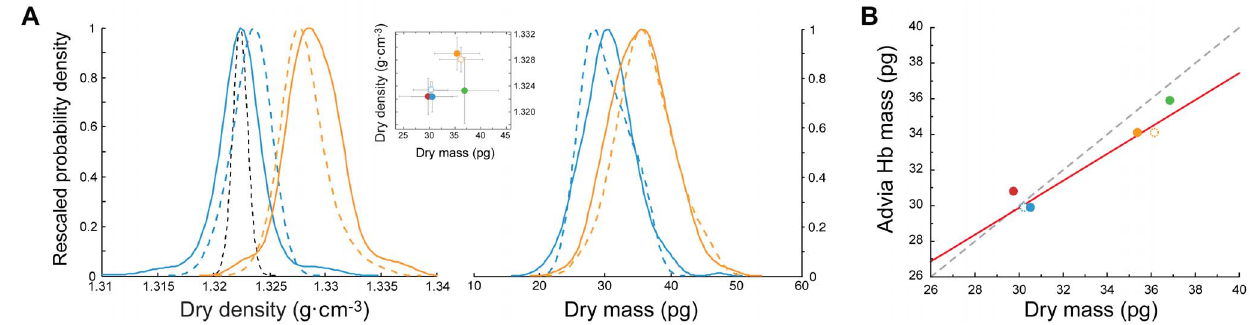
Figure 5. Dry density and mass of red blood cells. a) Single-cell dry density and dry mass distributions of two different human erythrocyte samples. Solid and dashed lines of same color indicate technical replicates. Dashed black line is a 99% bound on the expected dry density of a representative sample if all cells had the median dry density, given known measurement error. inset Population mean values from four patient samples. Error bars are standard deviation of the population. b) Comparison to hemoglobin mass per cell determined with an Advia instrument. Dashed line indicates y=x and solid line is a total least squares fit.